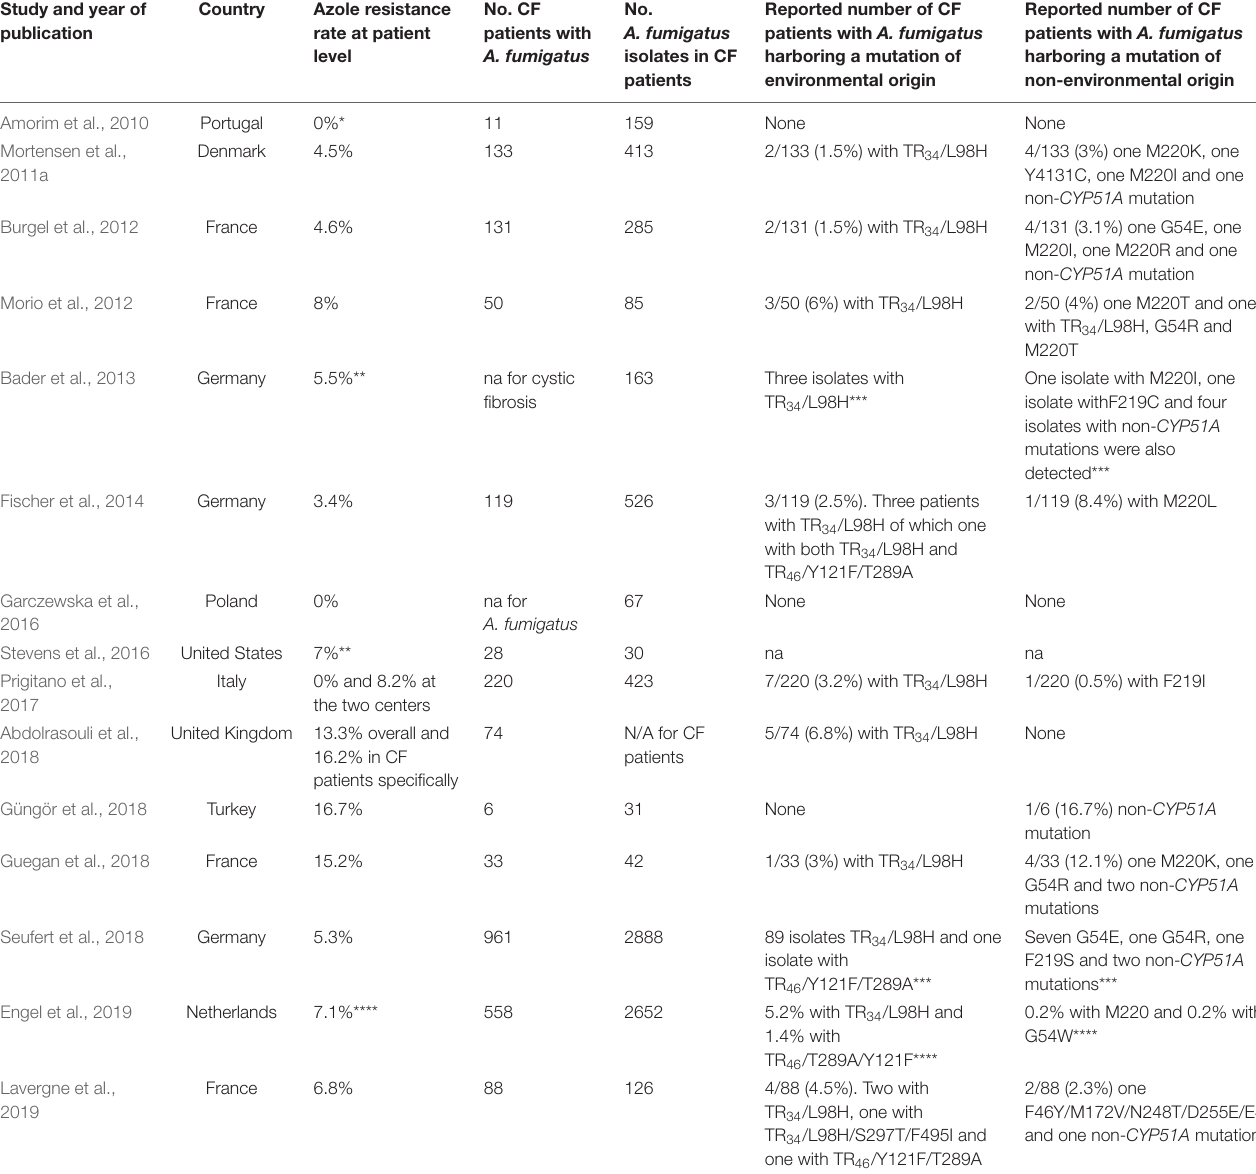
TABLE 1 | Review of published studies on azole resistance in patients with cystic